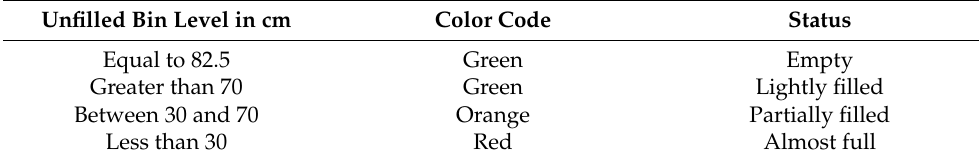
Table 1. Mapping table for the threshold unfilled levels and color code. Unfilled Bin Level in cm Color Code Status Equal to 82.5 Green Empty Greater than 70 Green Lightly filled Between 30 and 70 Orange Partially filled Less than 30 Red Almost